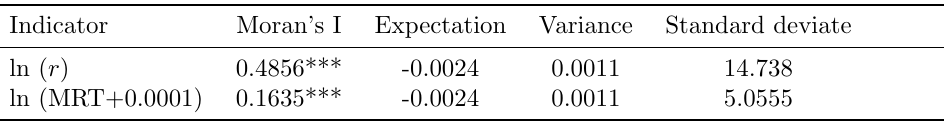
Table 9: Moran’s I-statistic for intrinsic growth rates and mortality (Weighting matrix: all adjacent